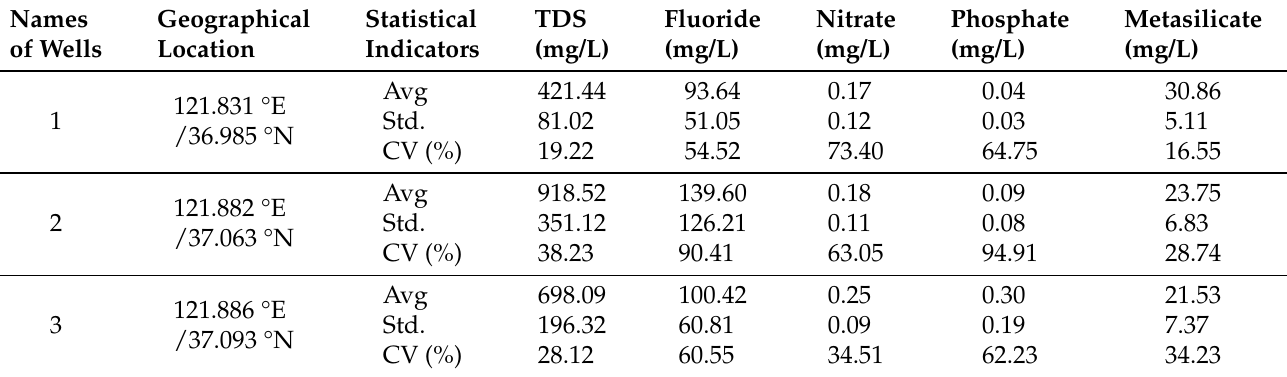
Table 4. Statistics of groundwater indicators concentration in the rainy